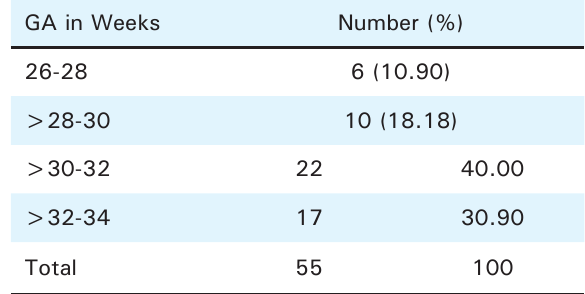
Table 1. Frequency and distribution of infants according to birth weight